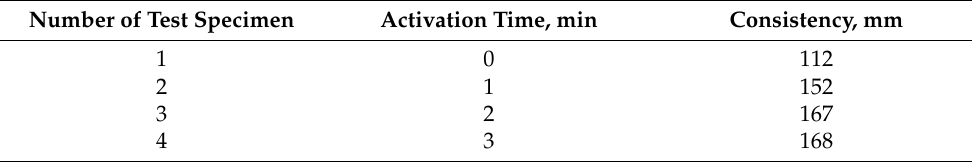
Table 4. Description of the consistency of the sapropel.